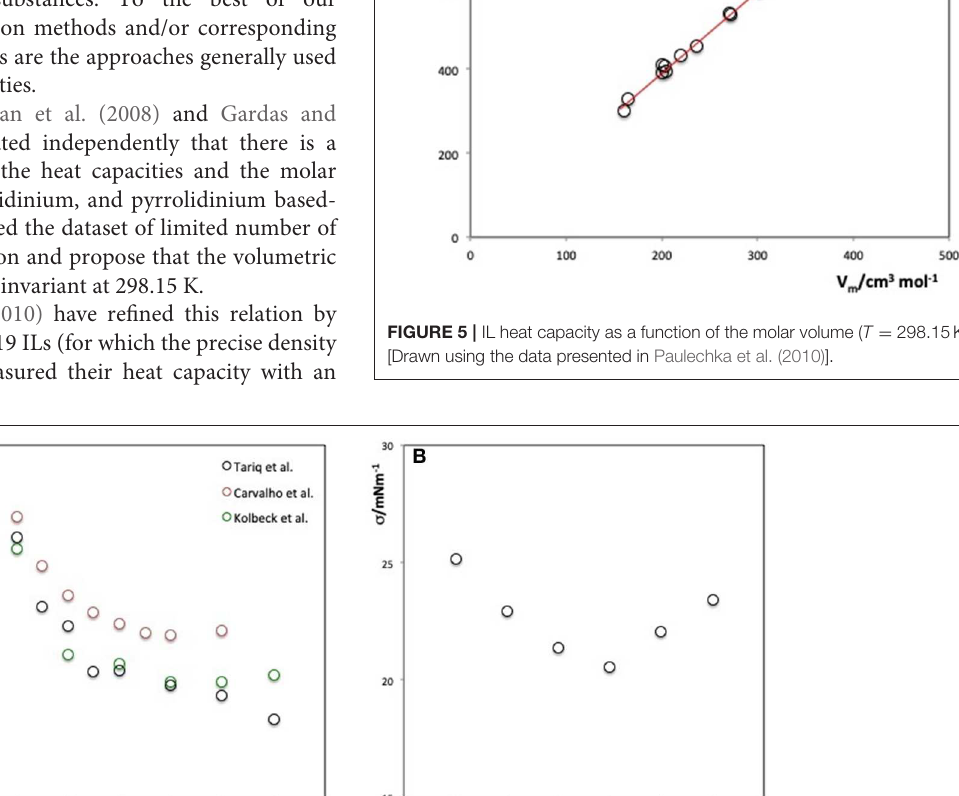
Frontiers in Chemistry |